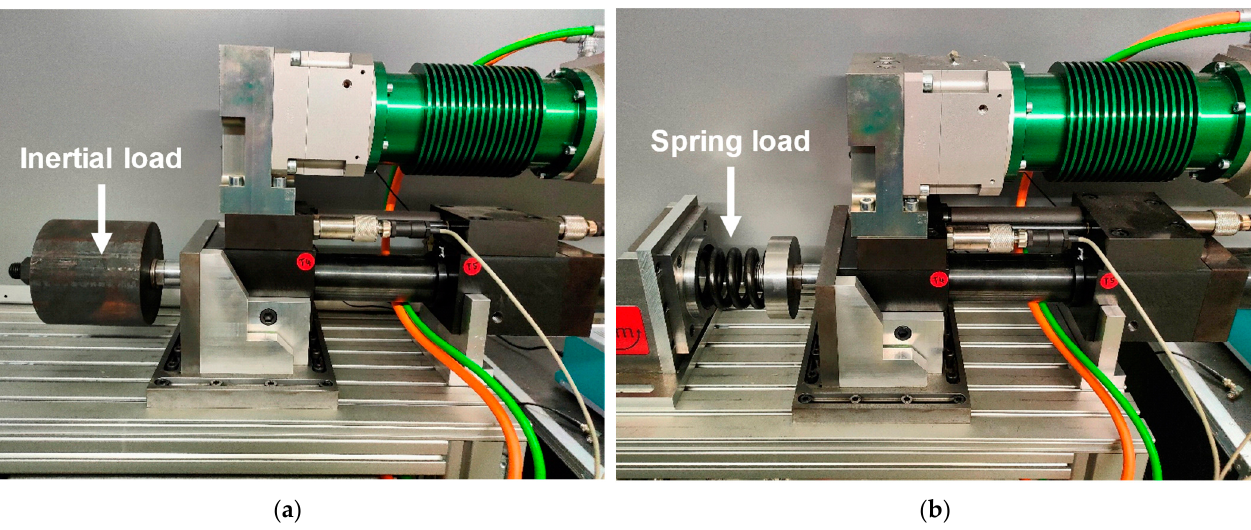
Figure 4. Modules for applying different loads to the EHA: ( a ) Inertia of 11.83 kg Modell and ( b ) Compression spring with stiffness of 241.381 N/mm.